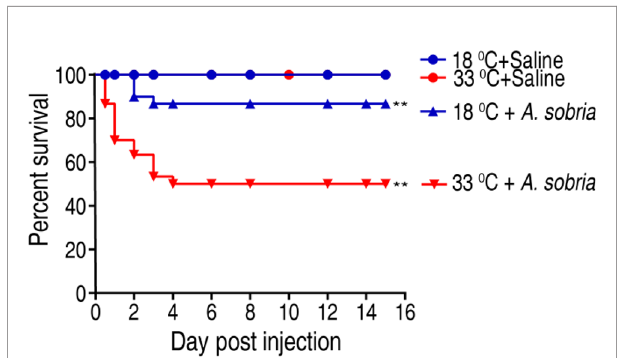
FIGURE 1 | Survival of GIFT (genetically improved farmed tilapia, Oreochromis niloticus ) to A. sobria infection cultured at 18°C and 33°C. Tilapias (n = 30 per group) were acclimated at 18°C and 33°C for 7 days before bacterial challenge. For bacterial infection, tilapias were injected with 10 µl 1 × 10 5 CFU/ fi sh A. sobria or 10 µl saline solution as negative control. Accumulative death was monitored for a total of 15 days. **p < 0.01.